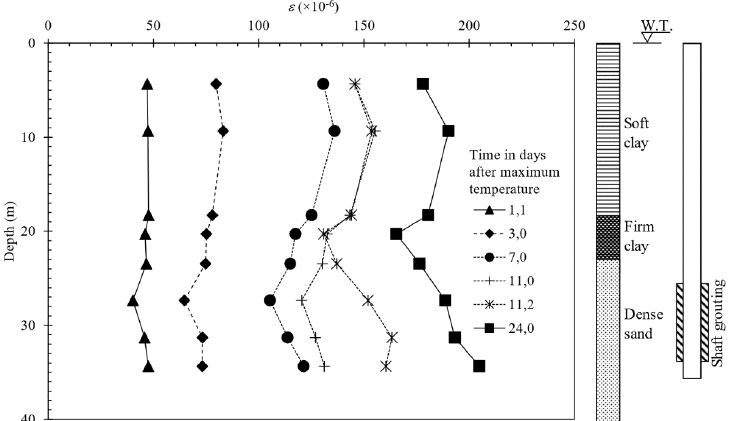
Figure 2. Strain measurements during the curing period for a drilled pile with 1.5 m diameter